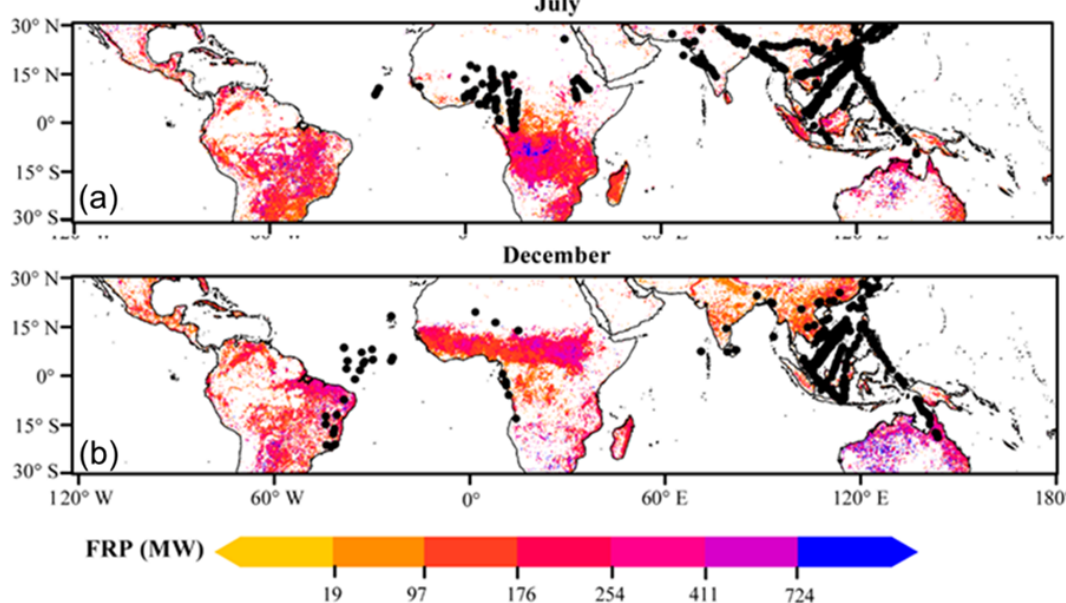
Figure 9. Spatial distribution of the fire radiative power (FRP) derived from MODIS on the Terra satellite (nadir pass at 13:30LT) for (a) July and (b) December (2011–2019). The black markers show the location of EIEs observed in each month.